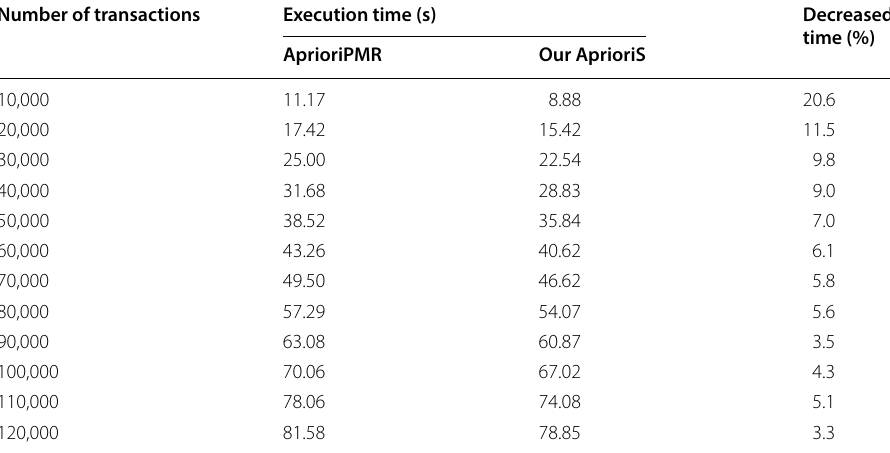
Table 3 Varying number of transactions